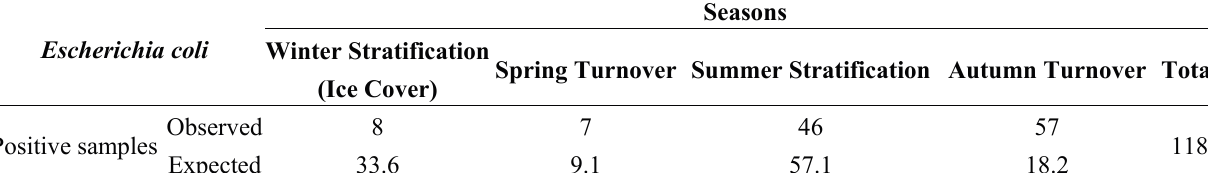
Table 2. Contingency table for chi-square test of Colifast ALARM Escherichia coli detection and different seasons (temperature stratification/turnover in the